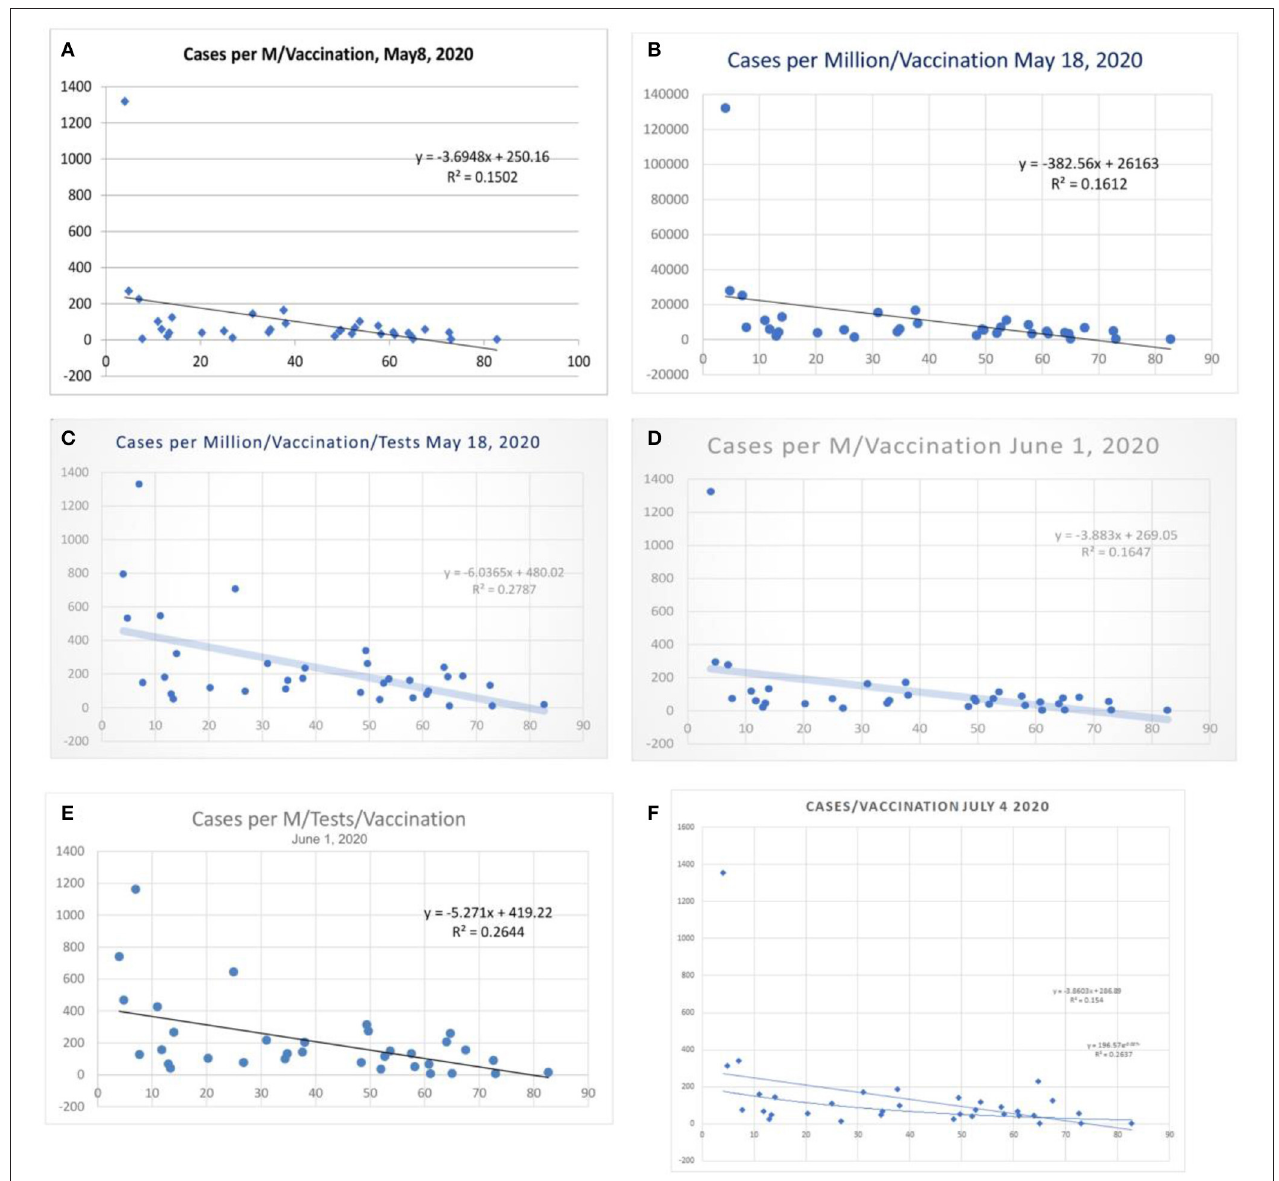
FIGURE 1 | Correlation between influenza vaccination percentage (age ≥ 65 years), and (cases per million population) vaccination percentage, (A) May 8, 2020, and (B) May 18, 2020. (C) Shows the case per-million value adjusted to tests performed (May 18, 2020) and (D,E) the data of June 1 2020. (F) Shows linear and logarithmic trendlines (July 4,